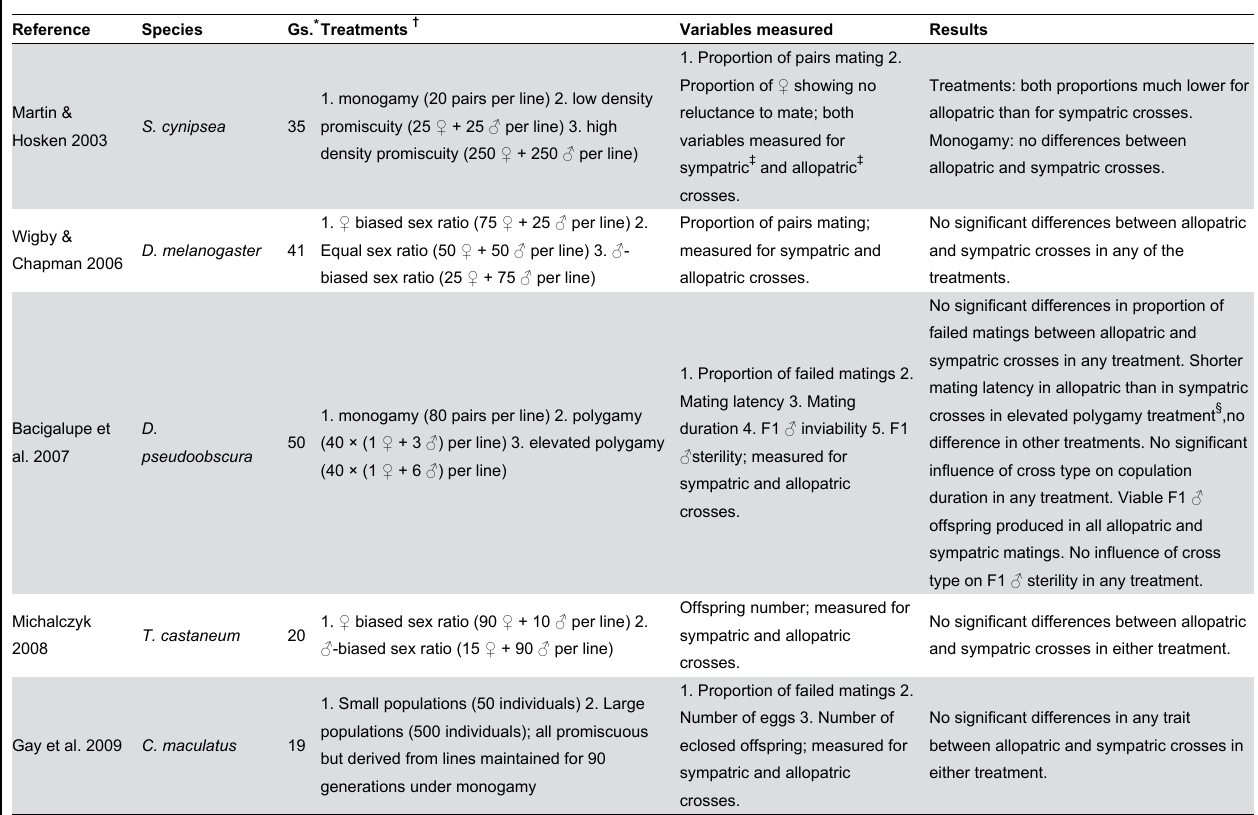
Table 1. Experimental evolution studies testing the hypothesis that sexual conflict drives reproductive isolation in